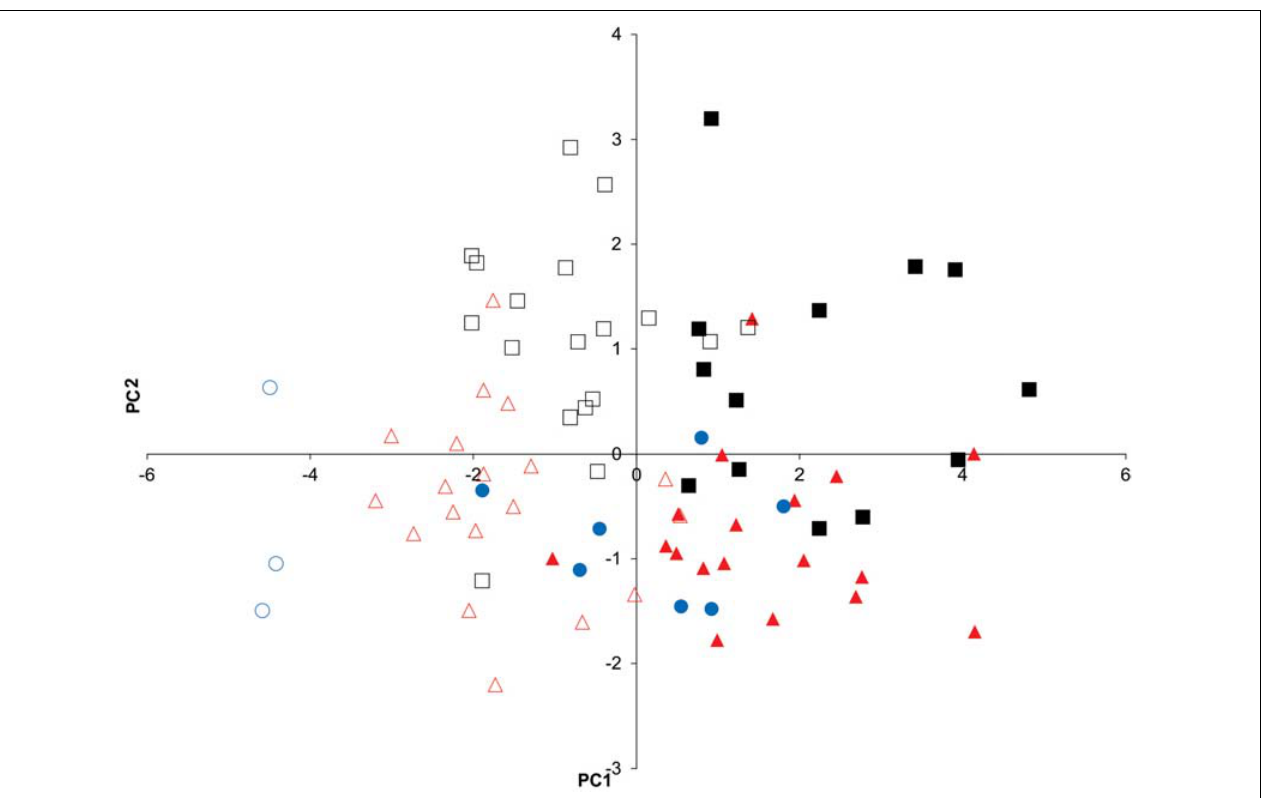
FIGURE 1 | Principal component (PC) analysis (PC1 vs. PC2) based on linear morphometric measurements of scapulocoracoids. The 1st 2 PCs explained 71.3% of the variance in the data. Psammobatis rudis males (black squares); P. rudis females (white squares); P. normani males (red triangles); P. normani females (white triangles); P. lentiginosa males (black circles); and P. lentiginosa females (white